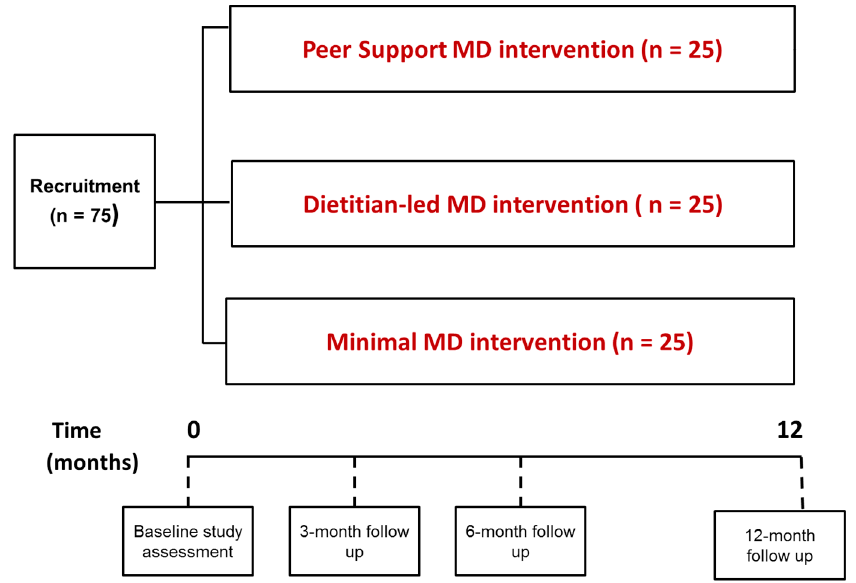
Figure 1. Overview of Trial to Encourage Adoption and Maintenance of a MEditerranean Diet (TEAM-MED) study design. MD: Mediterranean diet.